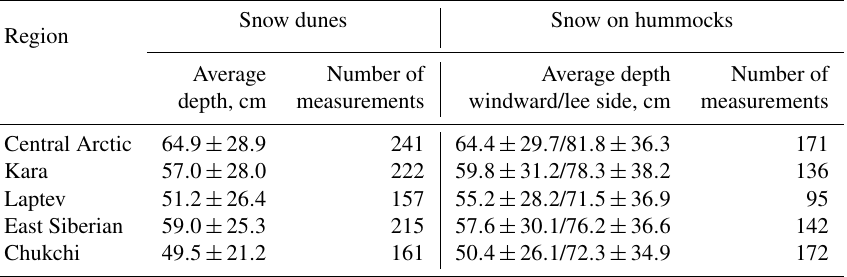
Table 4. Depth of snow in dunes extending out from ice ridges and on the hummocks in different parts of the Arctic. Snow Region